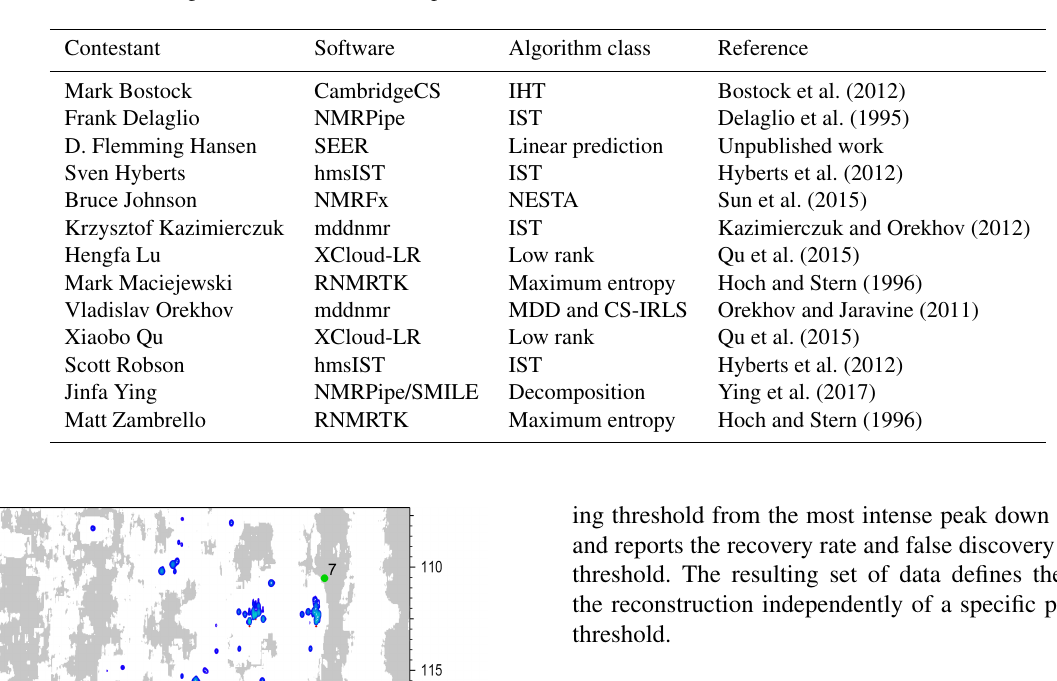
Table 3. Contestants and categorization of their chosen spectral reconstruction methods.